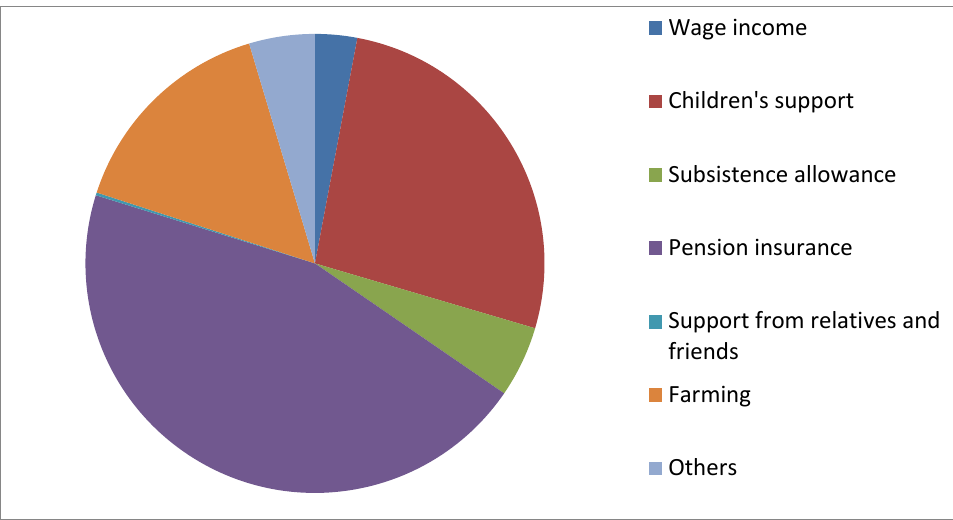
Figure 2. Main sources of financial income. Table 3. Relationship between filial piety expectation, filial piety income, and life satisfaction of empty-nest elderly in rural areas.